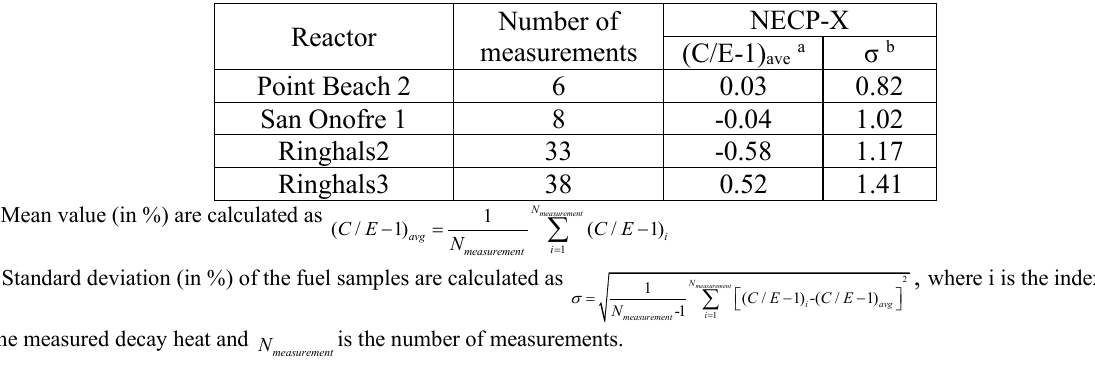
Table IV. Summary of average C/E-1 (%) for GE-Morris and CLAB